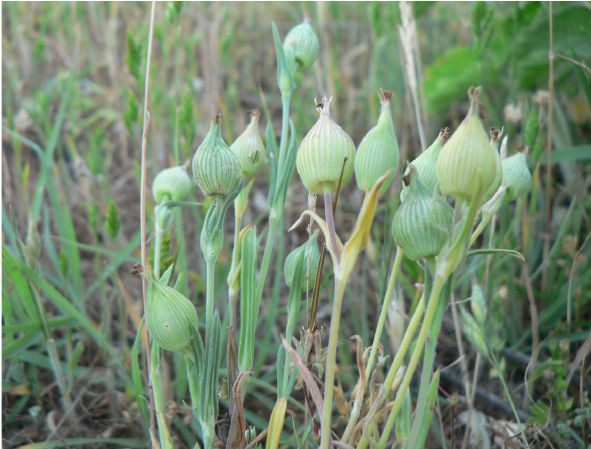
Fig. 4. Silene conica in the neighbourhood of Ciurumela